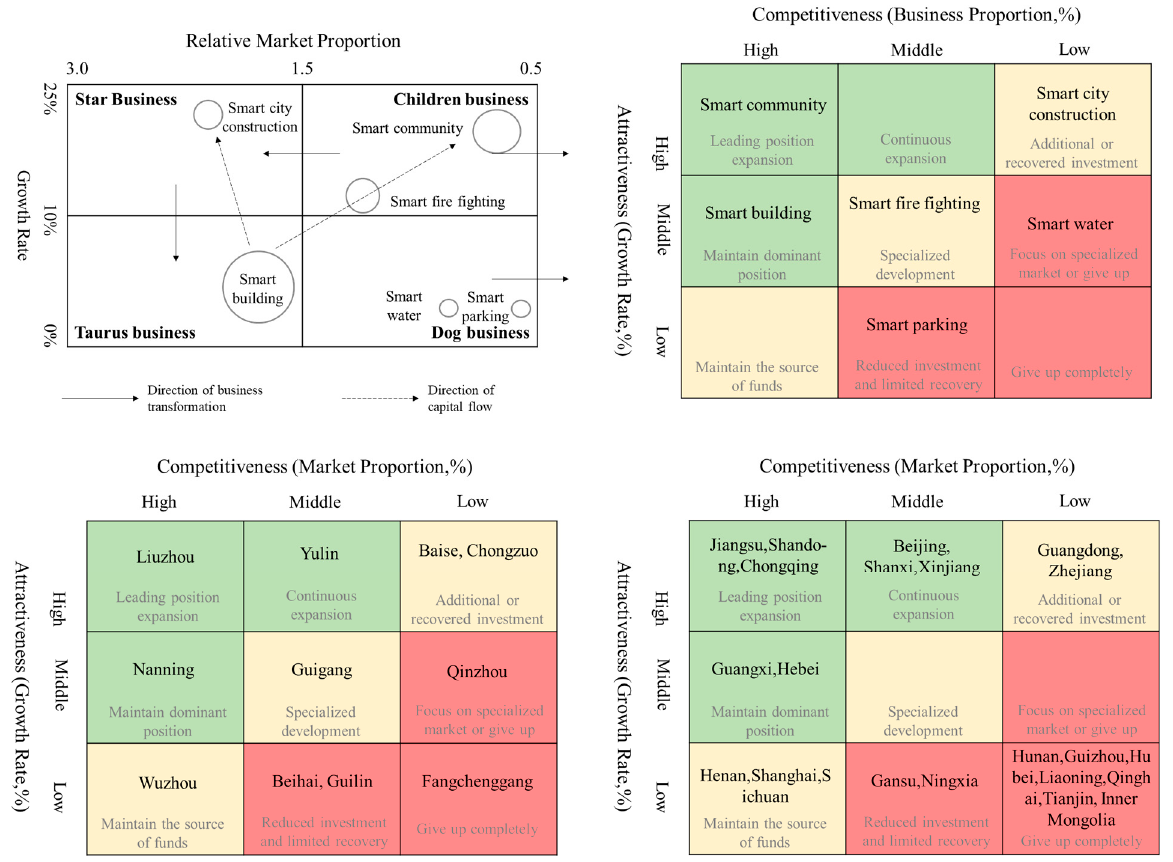
Figure 10. Analysis of important business and market, based on BCG and GE.